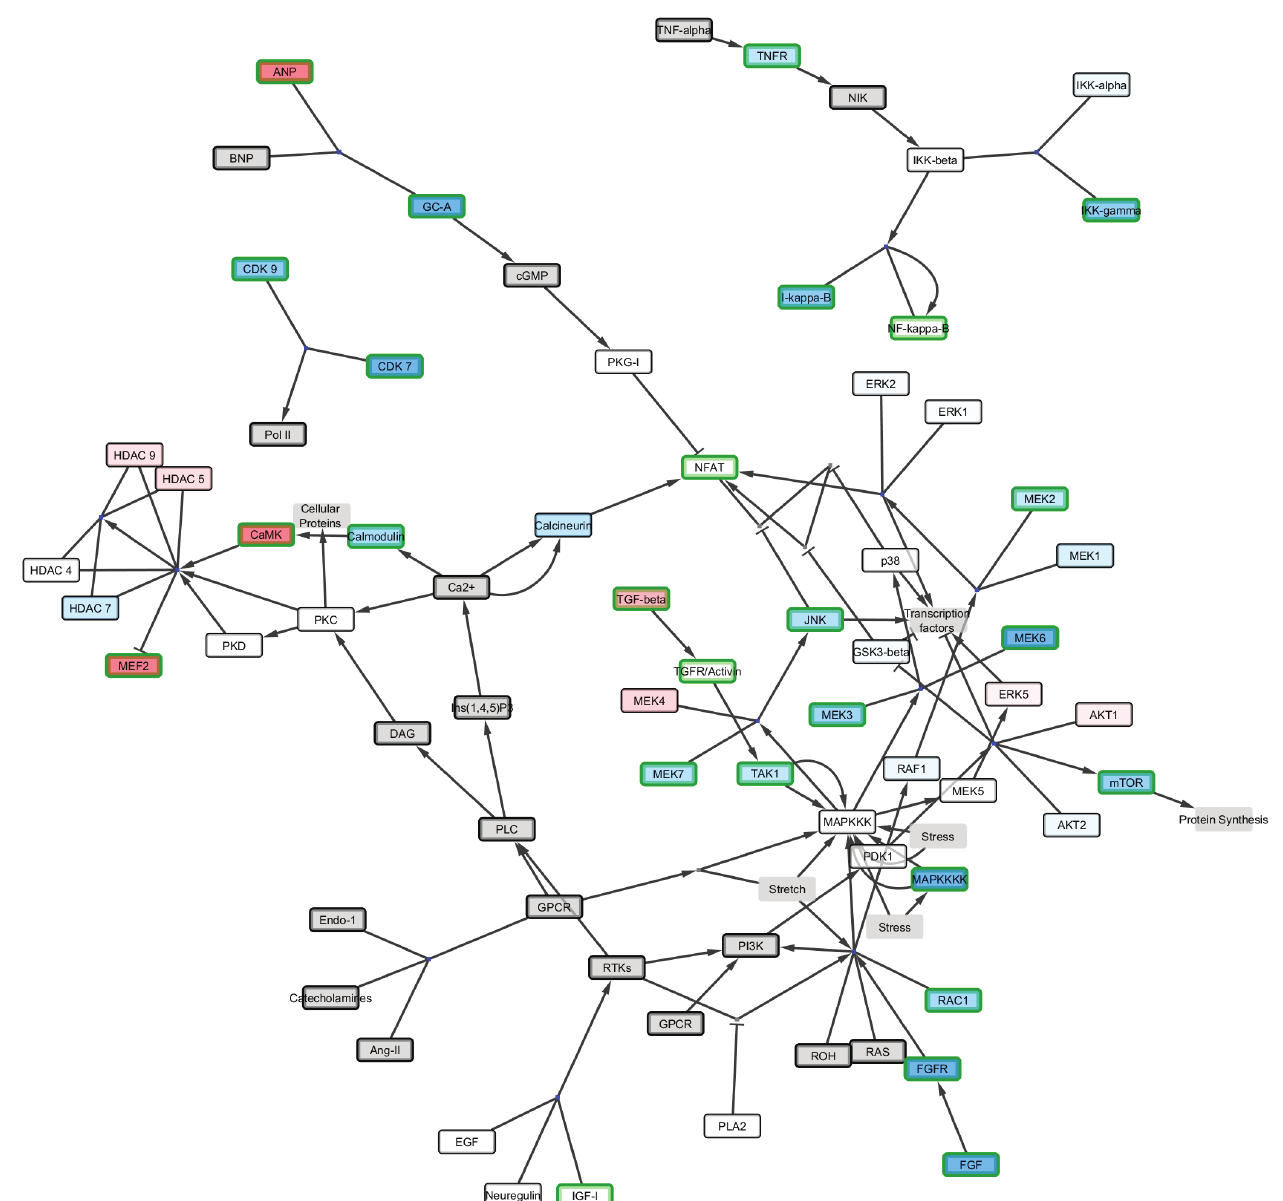
Supplementary Figure 4. Figure 2C in the WikiPathways App paper including all graphical details, e.g.